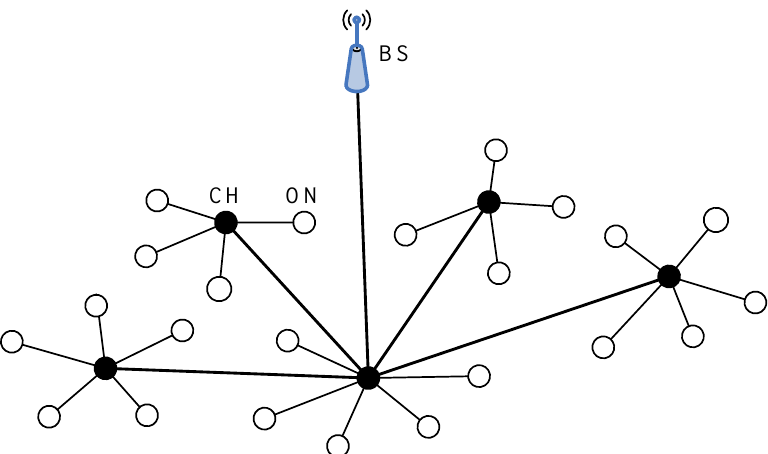
Figure 7. The Topology of the Network in BCDCP.